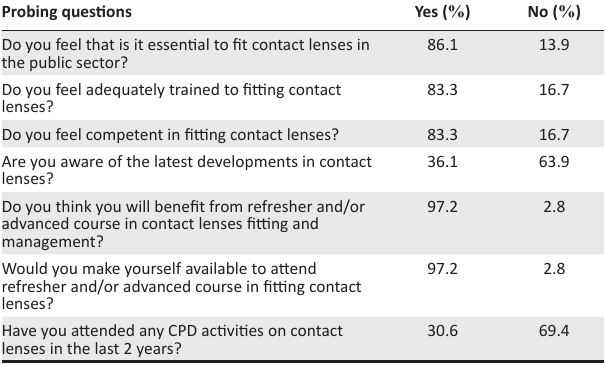
TABLE 4: Participant responses regarding contact lens